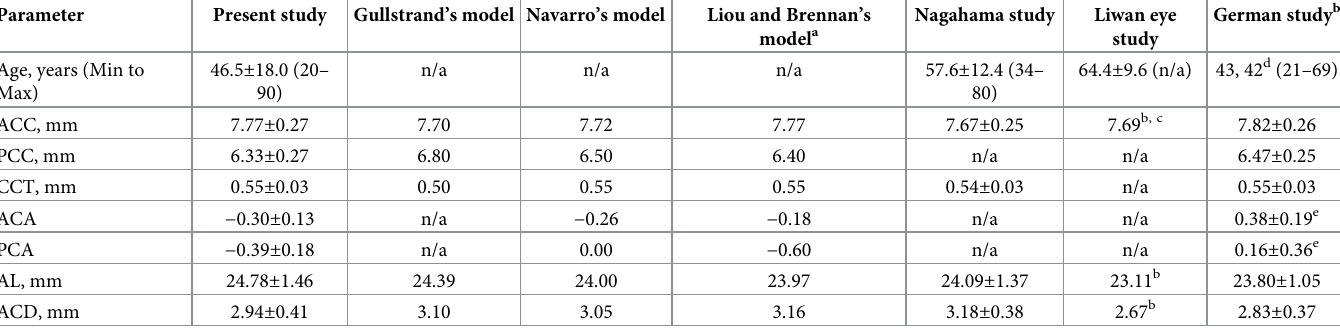
Table 2. Comparison of the eye shape results of this study and other eye models and previous studies [2,3,5,6,11,13].